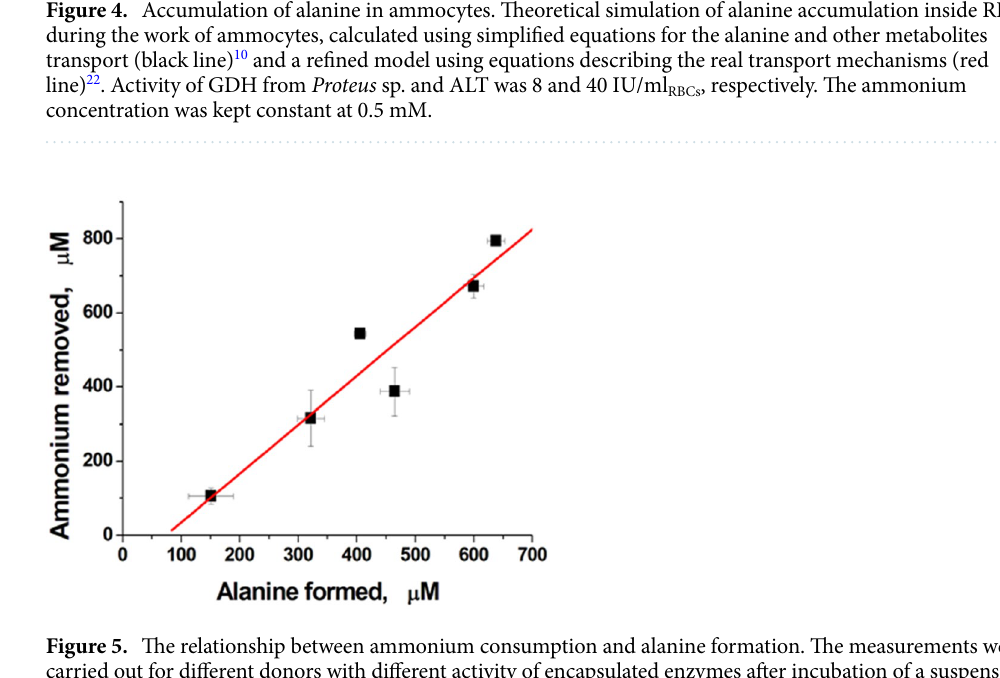
Theoretically, accumulation of alanine in ammocytes can inhibit ALT reaction and affect the efficiency of ammonium consumption by the erythrocyte-bioreactors. However, our results show that even in in vitro experi- ments with permanent significant alanine accumulation it does not affect the rate of ammonium consumption (Figs. 3, 5, 6). Consequently, we should not expect an influence of alanine on ammonium consumption rate under in vivo conditions, when alanine produced in the ammocytes is transported to blood plasma (Fig. 4). Finally, we would like to note that preclinical studies of a biomedical product such as erythrocyte-bioreactors are always a complex issue. Testing such a biomedical product will undoubtedly require studies of dose, sterility, stability, and other necessary parameters of the product for transfusion. Also, enzymes, especially heterologous, that are used for preparation of erythrocyte-bioreactors, can cause adverse immune reactions in case of adminis- tration to patients. However, entrapment of enzymes into erythrocytes prevents interaction of the enzymes with recipient immune system. That protects the enzymes from destruction by recipient’s immune system and prevents adverse immune reactions of recipient to the encapsulated enzymes. No significant adverse immune reactions